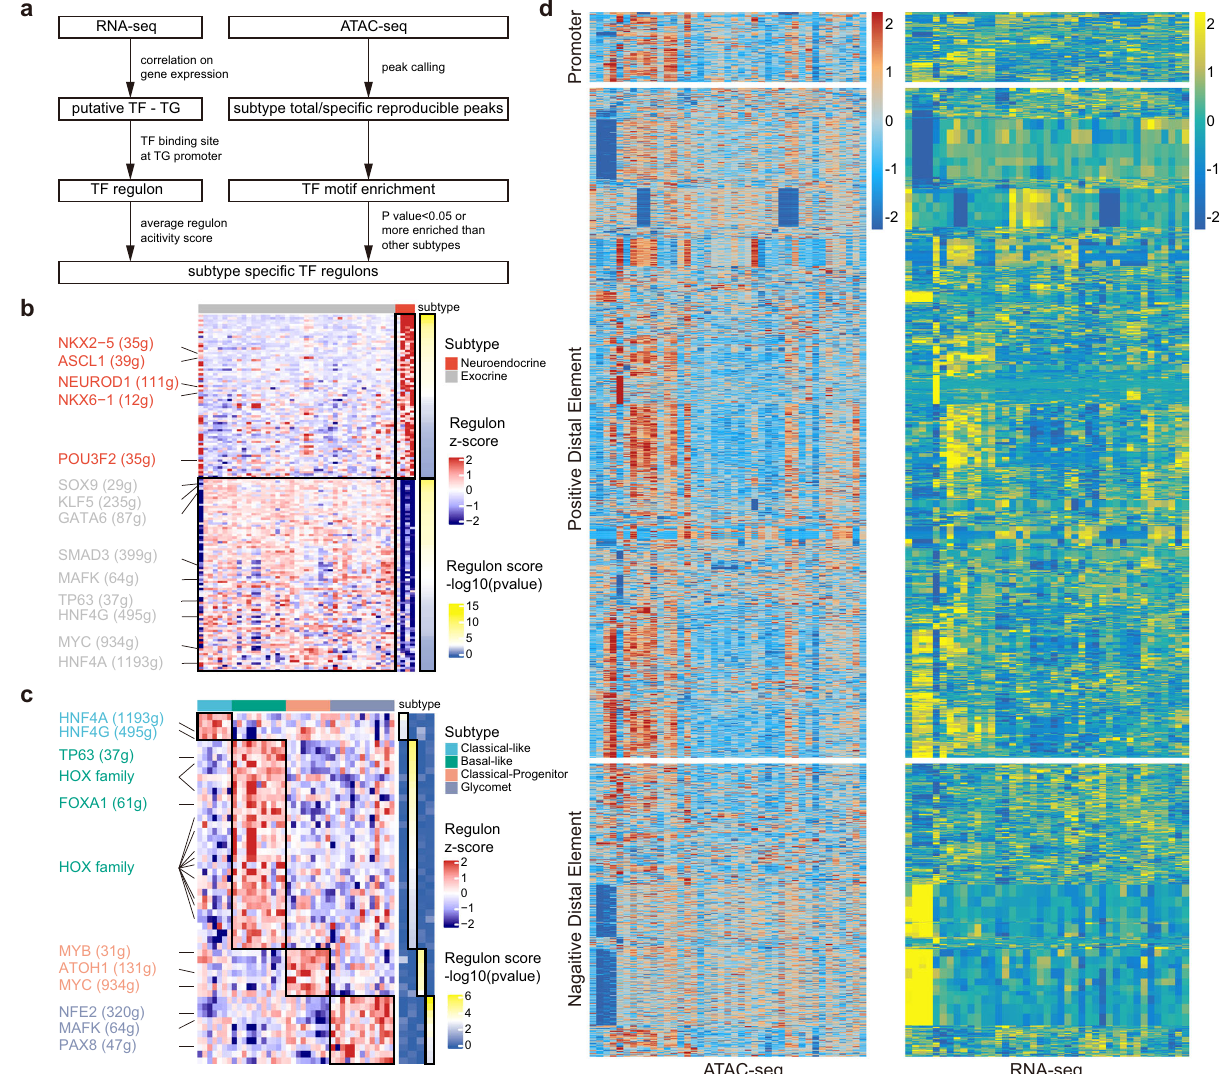
Fig. 4 Integrated analysis of RNA-seq and ATAC-seq revealing TF regulons for PDPCO subtypes and putative peak-to-gene links. a Schematic of the process for generating subtype-speci fi c TF regulons in PDPCOs. Comparison of enriched TF regulons between exocrine and neuroendocrine PDPCOs in b and among the four PDAC transcriptome subtypes in c . The color of each heatmap on the left represents the regulon z-score. The color of each heatmap on the right represents the -log10( P value) of the regulon score. P values associated with one-sided unpaired t test were adjusted for multiple testing using FDR. Representative subtype-speci fi c TF regulons are listed. d Heatmap of 2,257 putative links between ATAC-seq peaks (left) and genes (right) in 41 exocrine PDPCOs (39 PDACs, 1 IPMN, and 1 ACC). Each row represents an individual link between one ATAC-seq peak and one gene. The color of